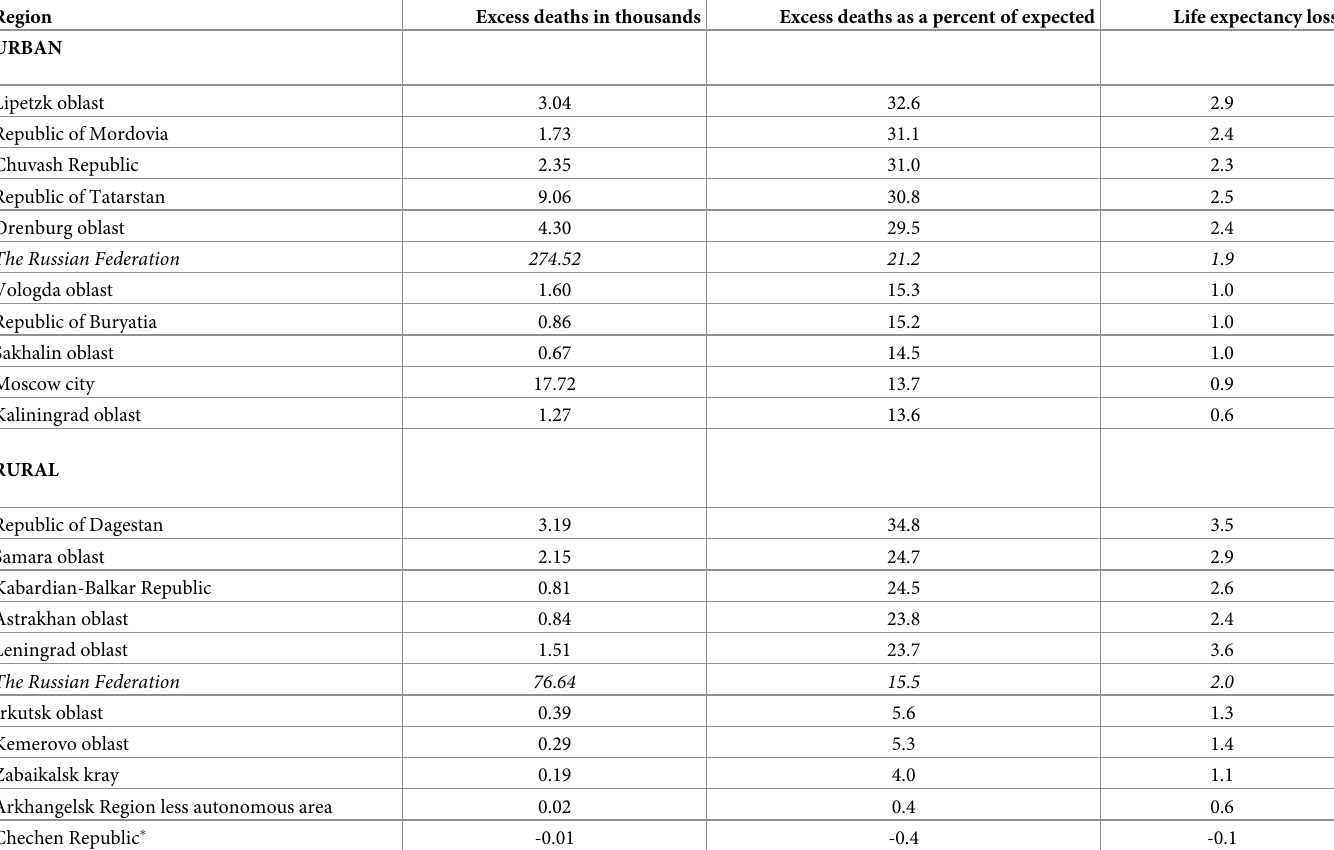
Table 2. Expected, observed and excess deaths (expressed in absolute and percentage terms), highest and lowest five regions of the Russian Federation with greater than 3,000 predicted deaths per year, 2020, urban and rural areas.